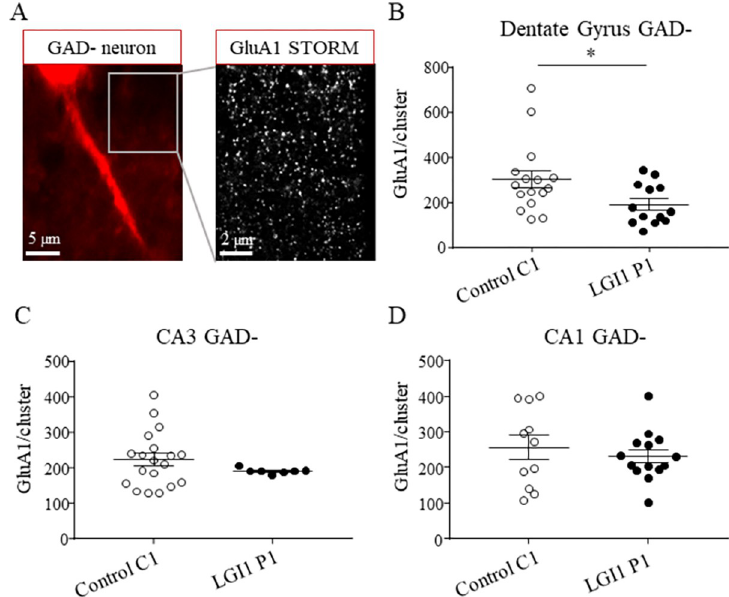
Fig 3. LGI1 Abs decrease the expression of AMPA-R inside clusters at the surface of excitatory neurons in the hippocampus. Epifluorescence images (100x objective) of GAD- region representing excitatory neurons (left image). The magnification showing the super-resolution STORM image of the expression of GluA1 subunits in the GAD- region (right image) (A). The total density of surface GluA1 subunits decreased after LGI1 P1 IgG infusion compared to control C1 IgG infusion in GAD- area in the DG of the hippocampus (Unpaired t test � p = 0.031, n Ctrl = 16 area, n LGI1 = 13 area) (B) but not in CA3 region (Mann-Whitney test p = 0.33, n Ctrl = 19 area, n LGI1 = 9 area) (C) nor CA1 (Unpaired t-test p = 0.49, n Ctrl = 11 area, n LGI1 = 14 area) (D). Data are represented as mean ± SEM (analysis realized from n Ctrl = 4 mice, n LGI1 = 3